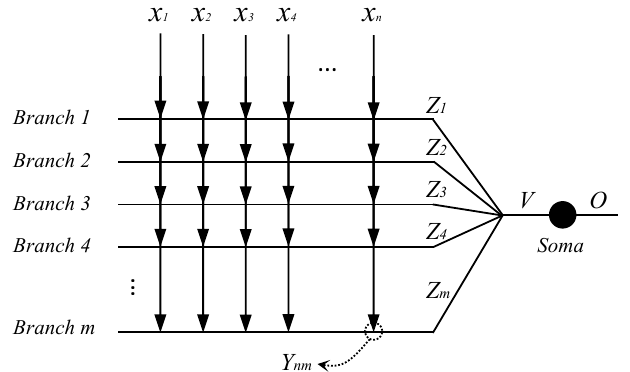
Figure 1. The logic architecture of the